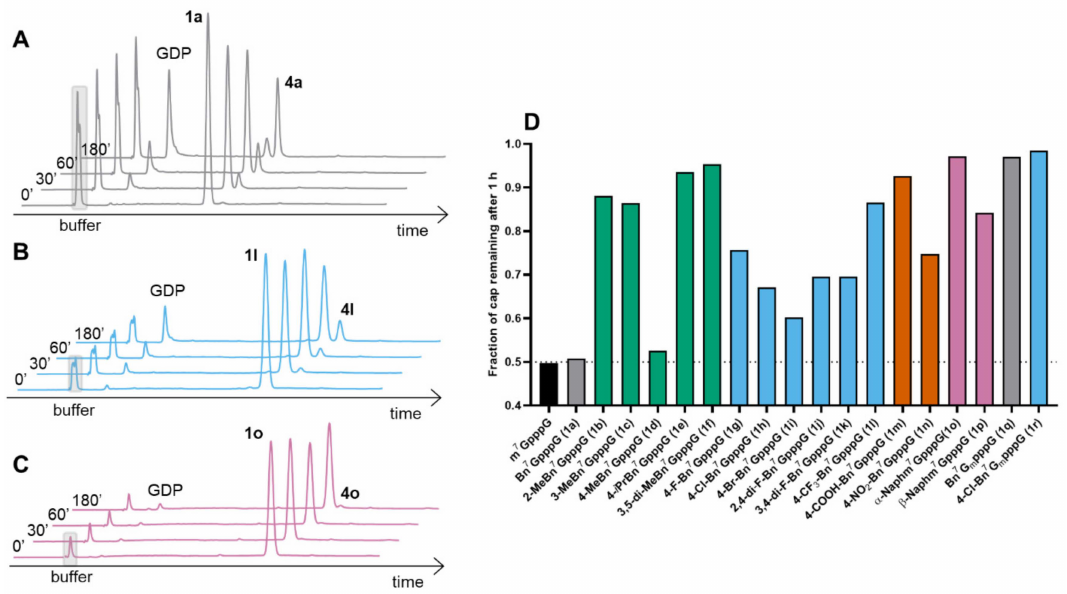
Figure 4. Susceptibility of cap analogs to the hDcpS enzyme studied via HPLC assay. Representative HPLC profiles from reaction mixtures containing Bn 7 GpppG, ( 1a , ( A )), 4-CF 3 -Bn 7 GpppG, ( 1l , ( B )) and α -Naphm 7 GpppG, ( 1o , ( C )). ( D ) The fraction of cap analog remaining after 1 h. The numerical values are summarized in Table 2. G m : 2 (cid:48) - O-